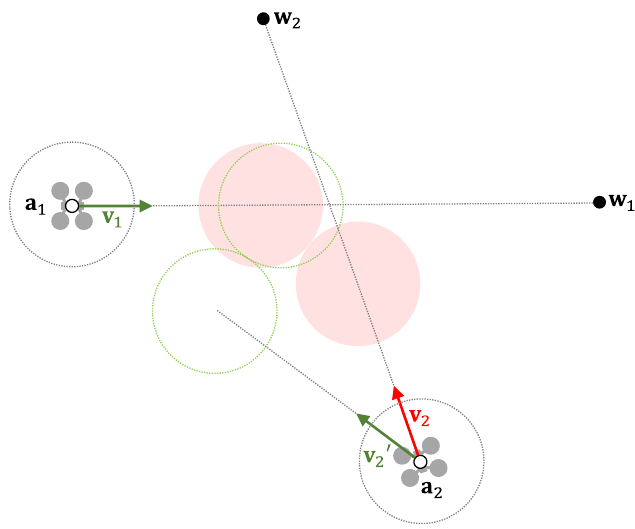
Figure 3. Conflict resolution between UAVs with different priorities.